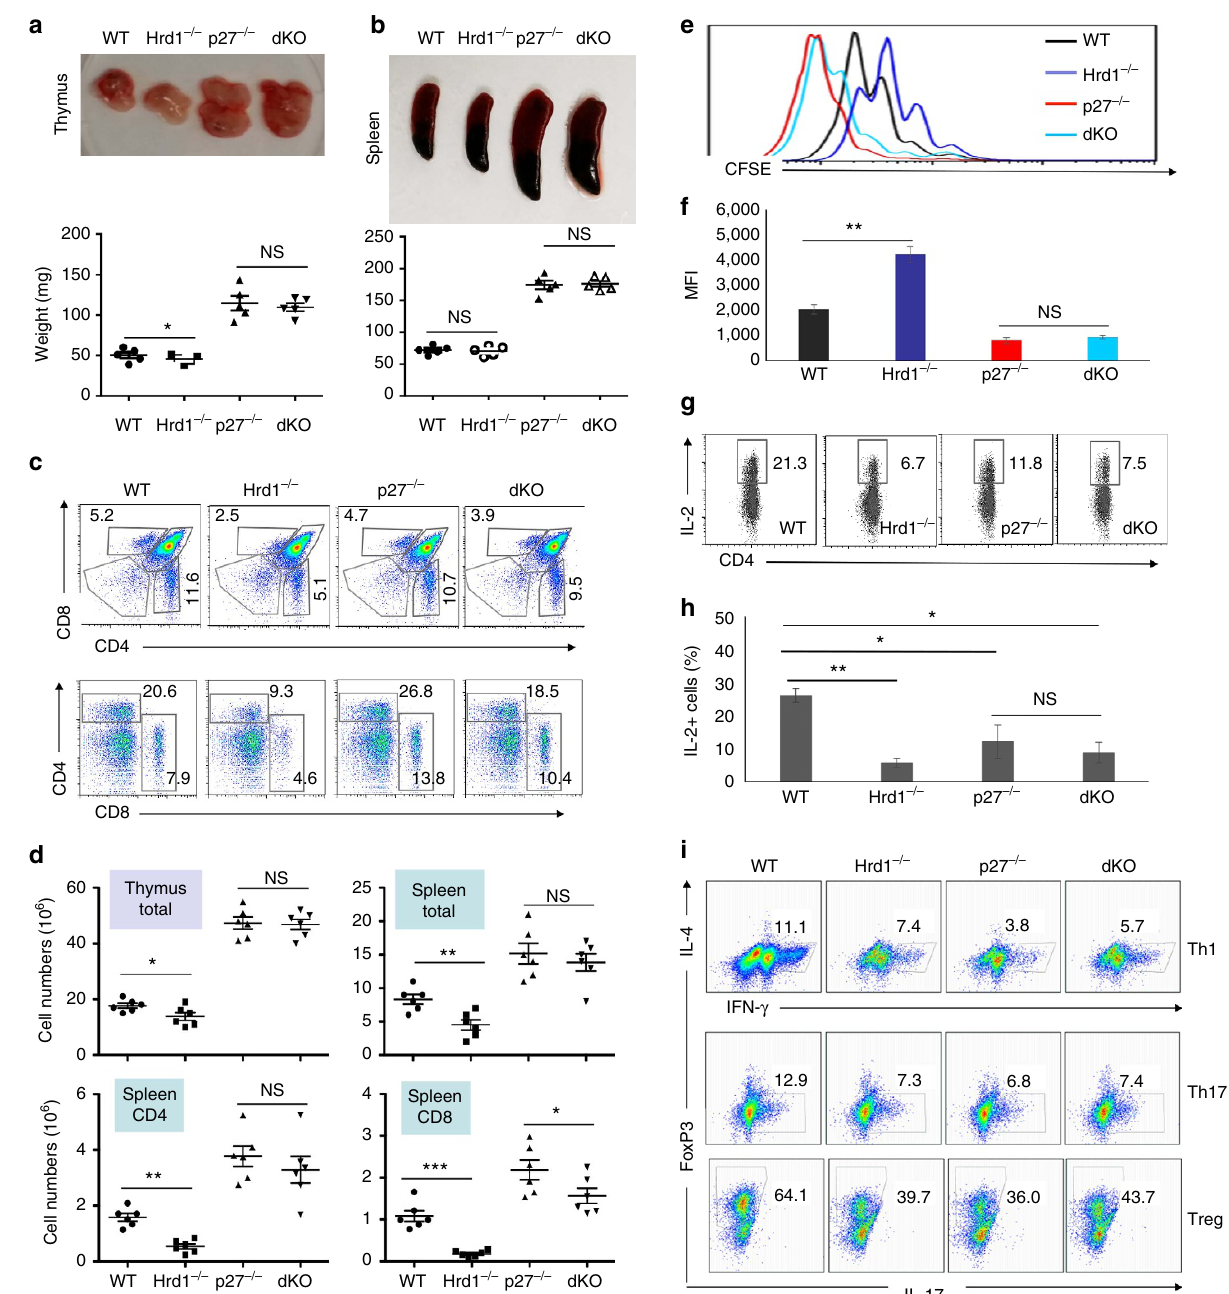
Figure 5 | Hrd1 regulates T-cell activation partially through p27 kip1 . ( a , b ) Thymus ( a ) and spleen ( b ) were isolated from 8–10-week-old WT, Hrd1 cKO, p27 kip1 KO and double KO (dKO) mice. Representative images (top panels) and the weights in milligrams (mg; bottom panels) are shown. ( c , d ) Single-cell suspensions from the thymus and spleen were analysed by cell surface staining of CD4 and CD8. Representative flow data ( c ) and the absolute numbers of each indicated population from five sets of mice ( d ) are shown. ( e – h ) Naive CD4 Tcells from WT, Hrd1 cKO, p27 kip1 KO and dKO mice were stained with CFSE and cultured with anti-CD3 plus anti-CD28. Cell proliferation ( e , f ) and IL-2 production ( g , h ) were determined. Representative images ( e , g ) and data from five independent experiments are shown ( f , h ). ( i ) Naive CD4 T cells from WT, Hrd1 cKO, p27 kip1 KO and dKO mice under Th1, Th17 or Treg polarization conditions. The production of each indicated cytokines or FoxP3 expression was analysed by intracellular staining. Representative images are shown here and the results from five independent experiments are indicated in Supplementary Fig. 8. Mann–Whitney test was used for the statistical analysis. NS, no significant difference; * P o 0.05, ** P o 0.01 and ***P o